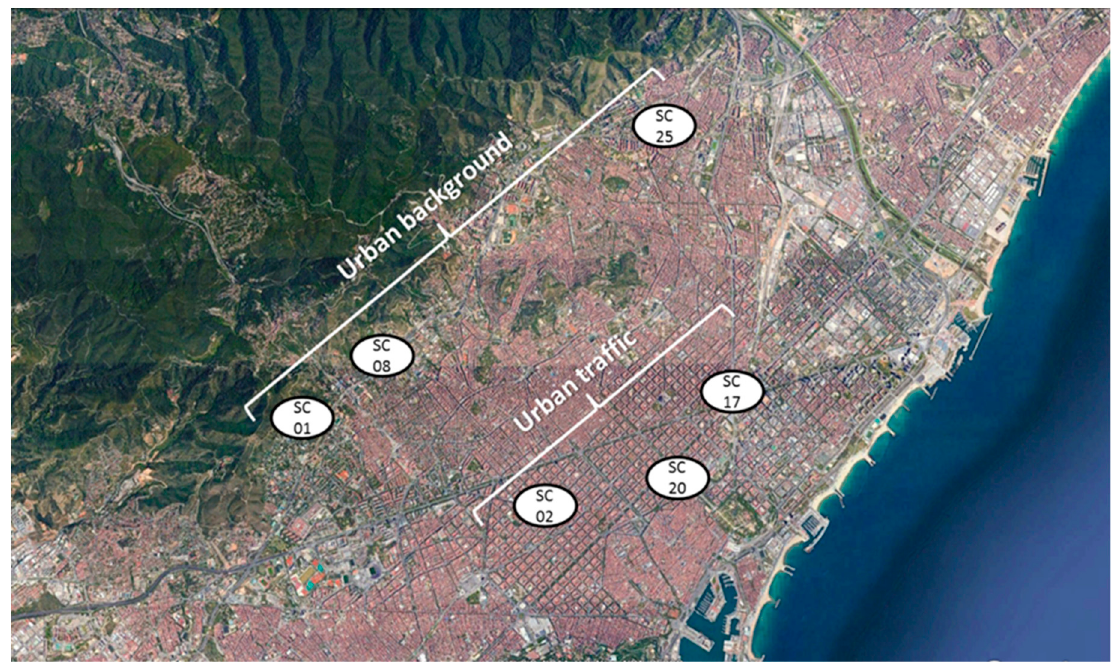
Figure 1. Schools selected for study in the urban background and traffic intensive areas of the Barcelona metropolitan area.